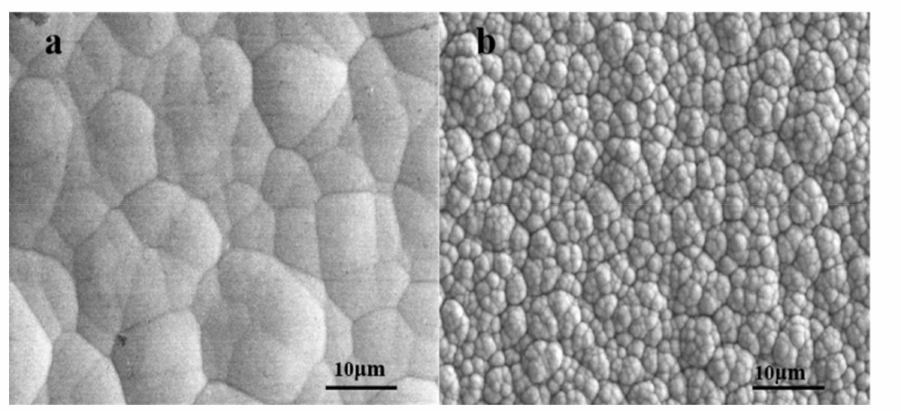
Figure 9. SEM images of the ( a ) NiP, and ( b ) NiCrP alloy